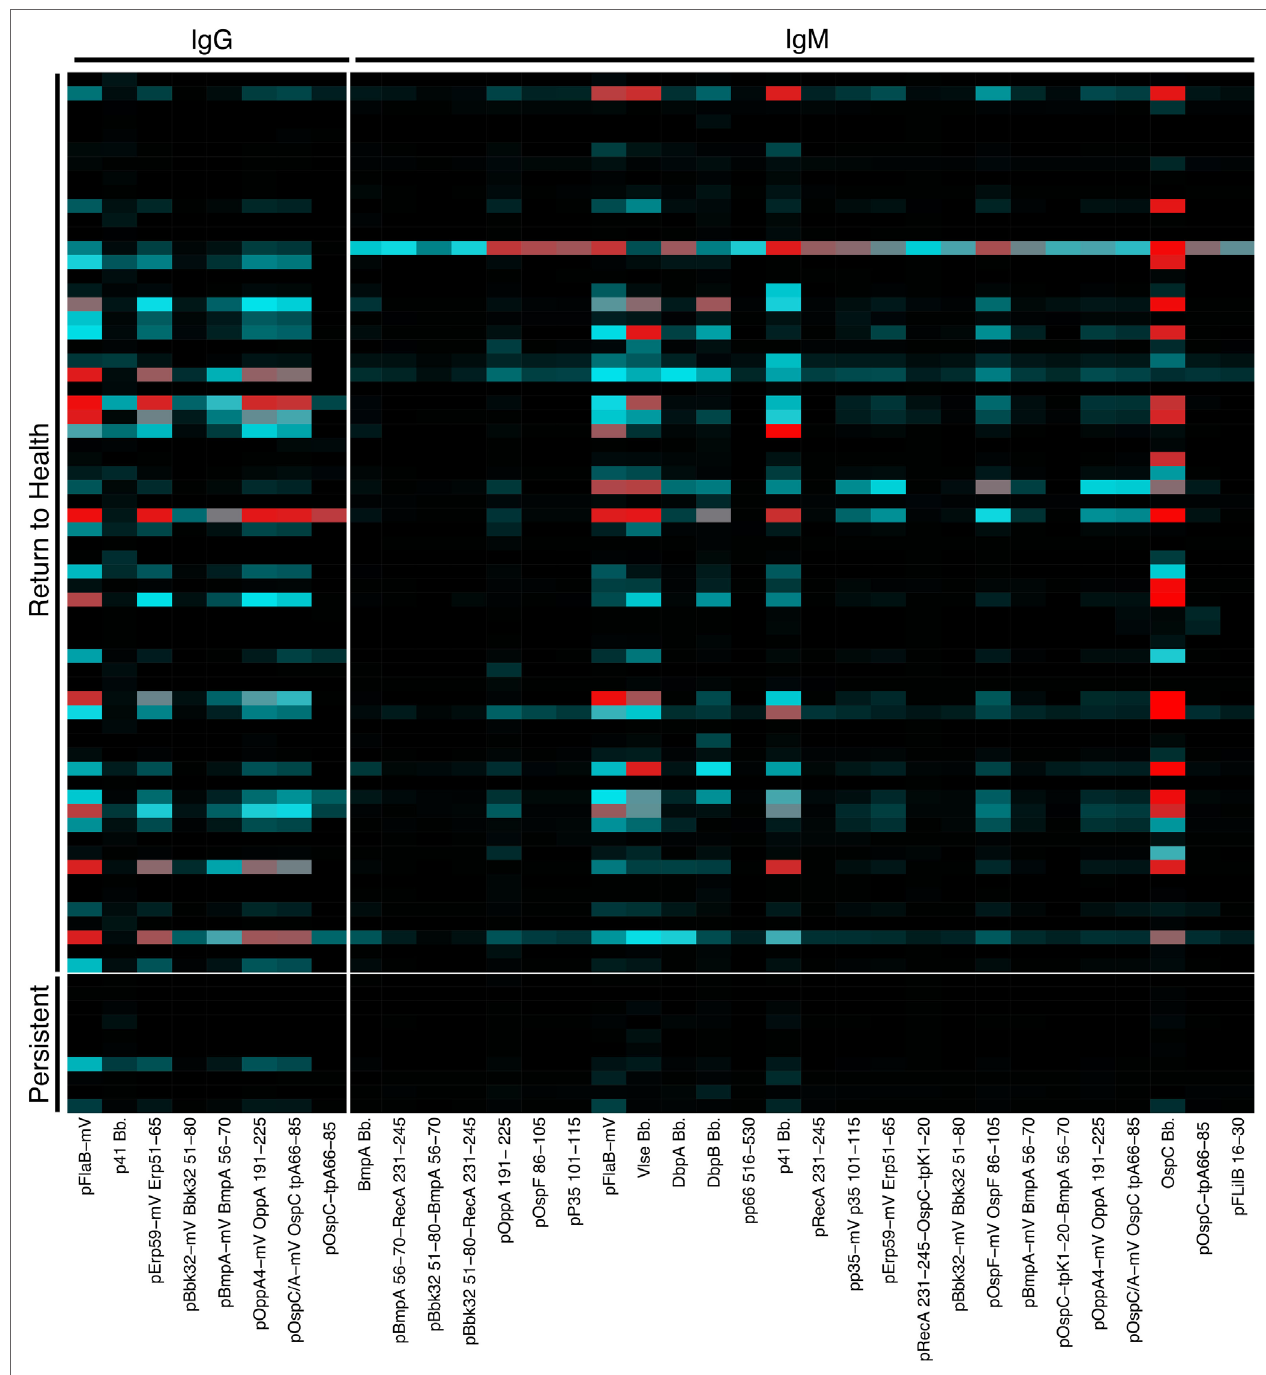
FigUre 2 | Serum reactivity to Bb surface proteins is stronger in patients who return to health following treatment. Serum IgG and IgM reactivity to 62 Bb surface proteins and peptides was measured in a previously published study to assess the diagnostic utility of these markers (12). Based on observed differences in B cell populations ( Figure 1 ), serum Luminex data were reanalyzed to assess differences between recently infected Lyme disease patients who reported persistent symptoms and those who returned to health following treatment. Mean fluorescence intensities (MFI) were compared using Significance Analysis of Microarrays, and the MFI of markers with significantly different reactivity are displayed on the